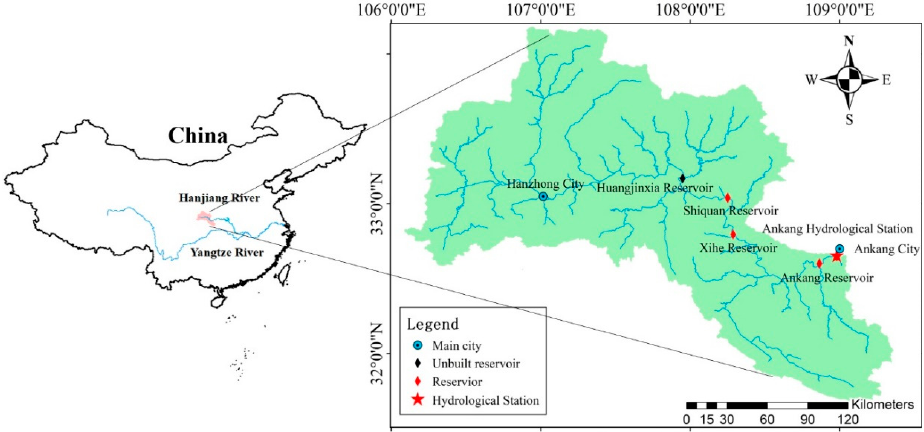
Figure 1. Map of the upper Hanjiang Basin above the Ankang hydrological station.